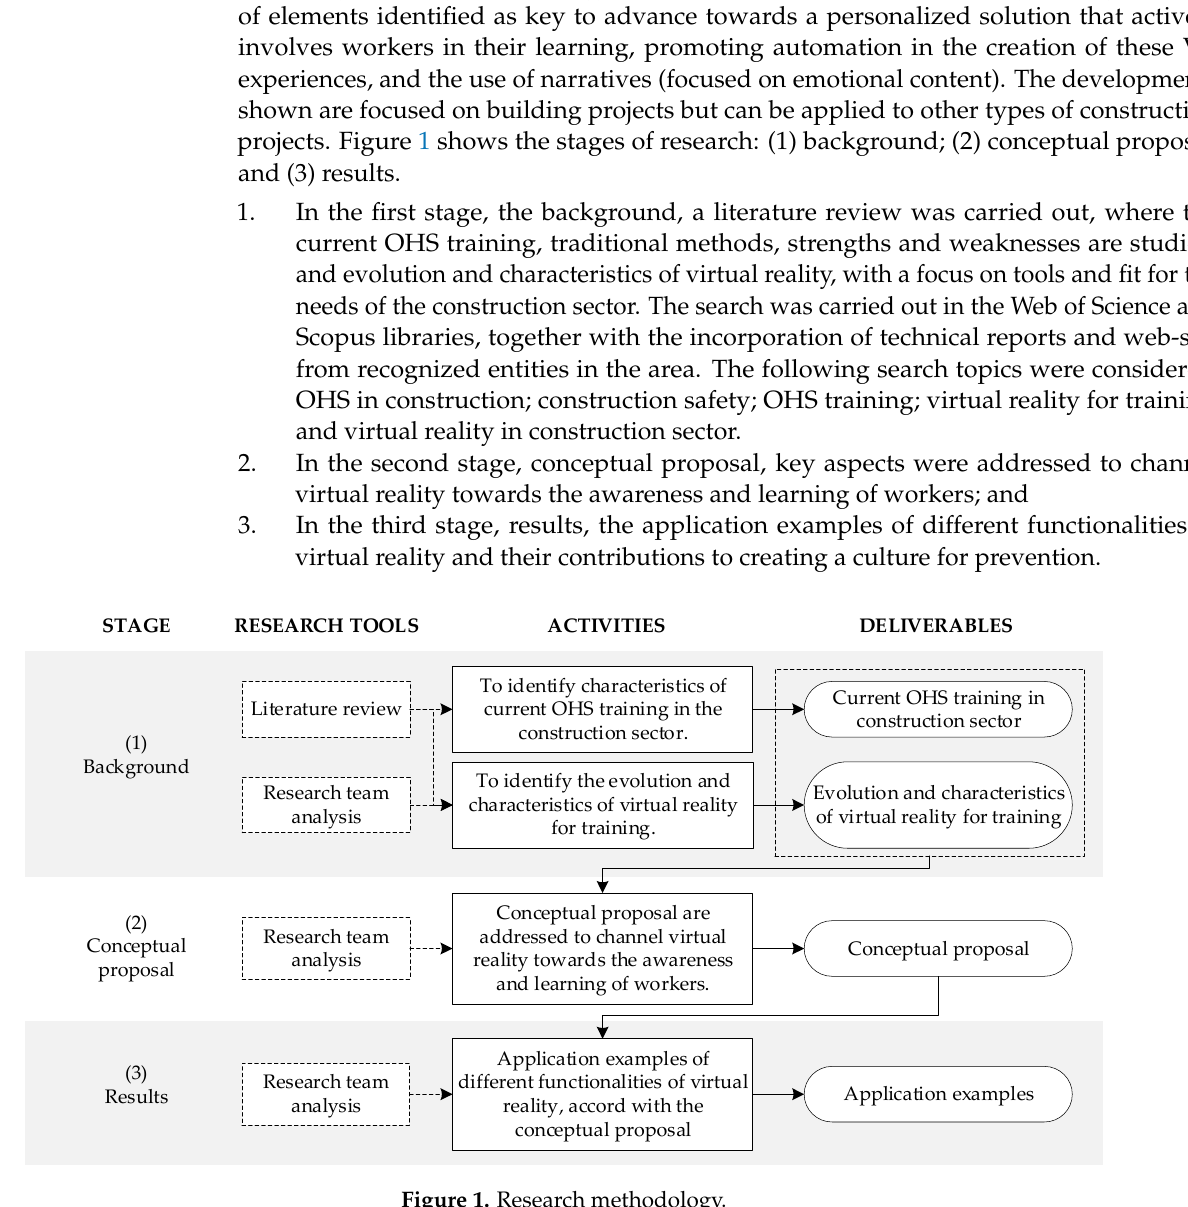
Figure 1. Research methodology.